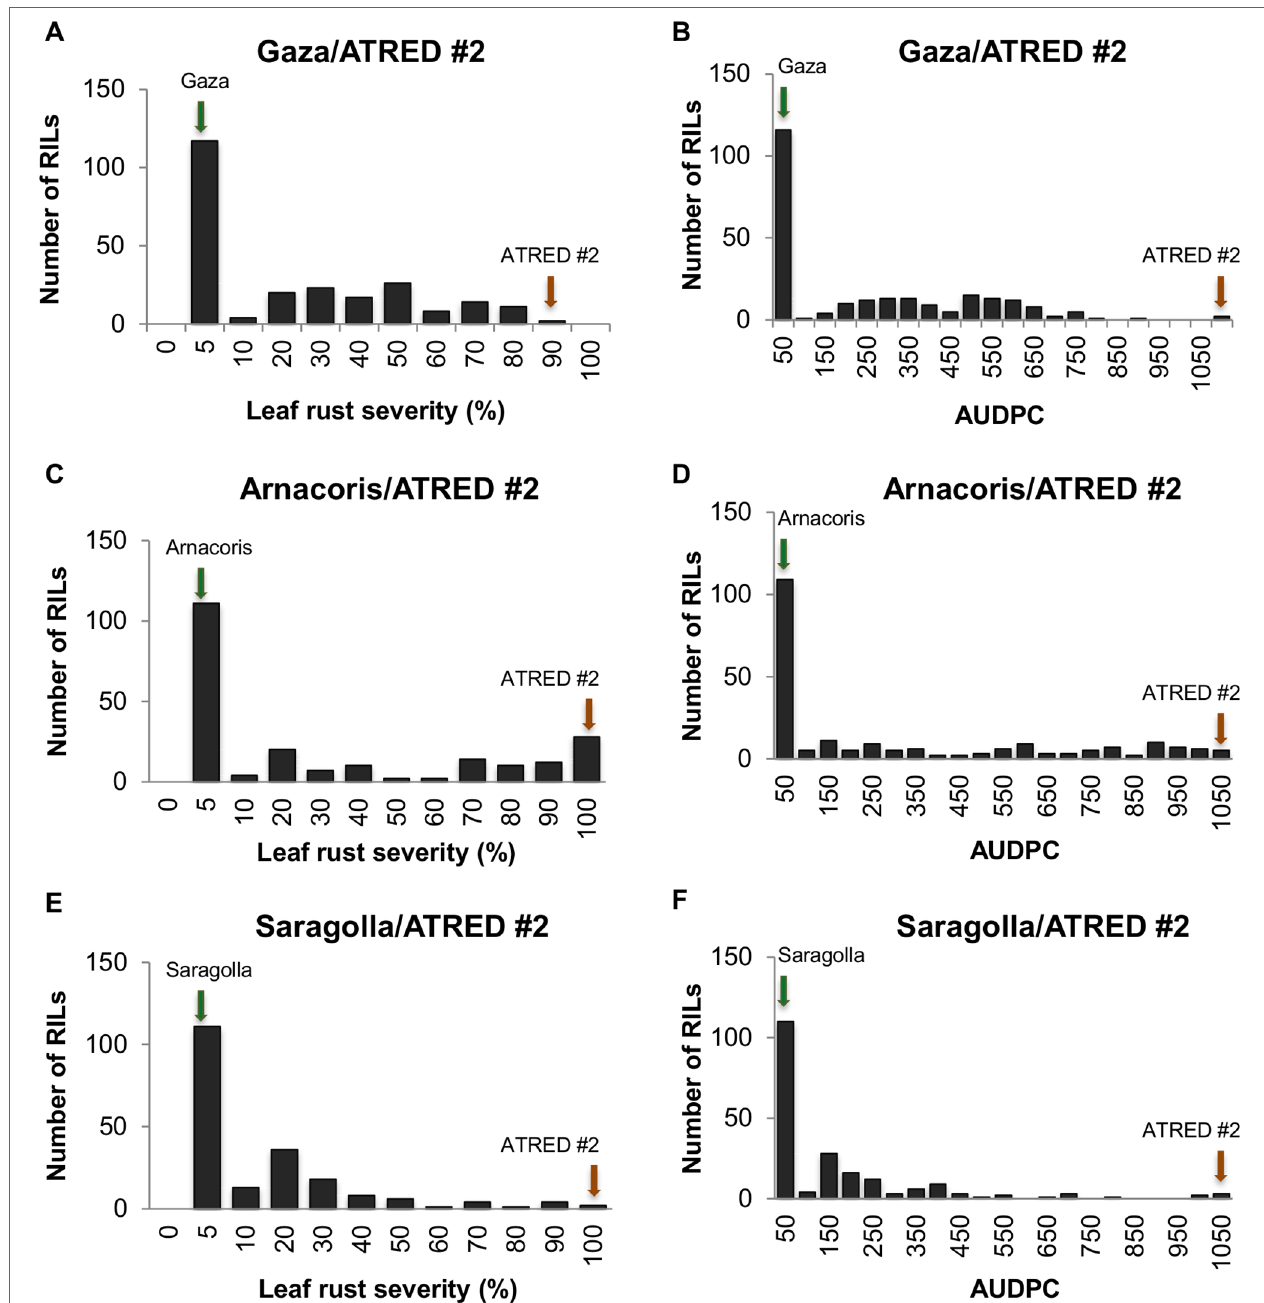
FIGURE 1 | Frequency distributions of leaf rust severity and AUDPC in adult plants of the three RIL populations, evaluated for leaf rust reaction to the Mexican race BBG/BP in field plot tests. Panels represent (A) LRS for Gaza/ATRED #2, (B) AUDPC for Gaza/ATRED #2, (C) LRS for Arnacoris/ATRED #2, (D) AUDPC for Arnacoris/ATRED #2, (E) LRS for Saragolla/ATRED #2, (F) AUDPC for Saragolla/ATRED #2. Green arrows indicate positions of the resistant parents, and red arrows indicate positions of the susceptible parent ATRED